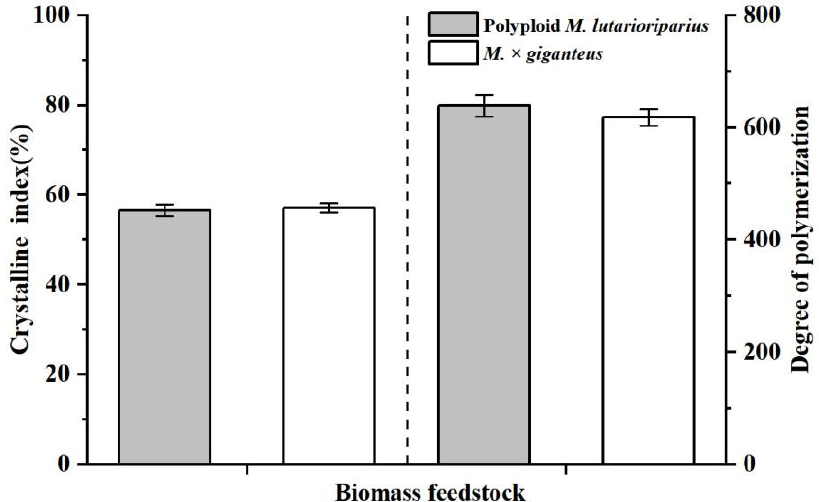
Figure 3. Crystalline index and degree of polymerization of lignocellulosic biomass in polyploid Miscanthus lutarioriparius and Miscanthus × giganteus . Vertical bar are standard deviation ( n = 3).